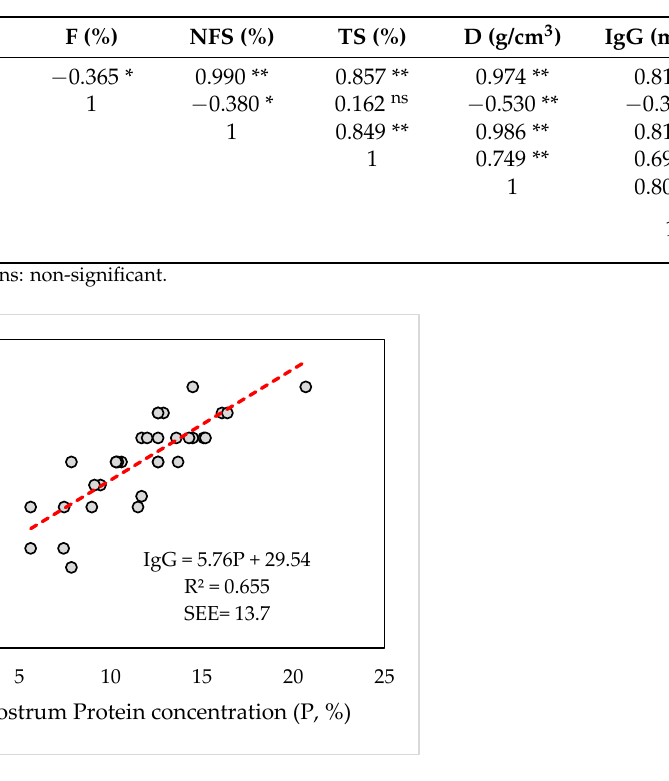
Table 6. Pearson ’s correlation matrix for the components of ewe’s colostrum.